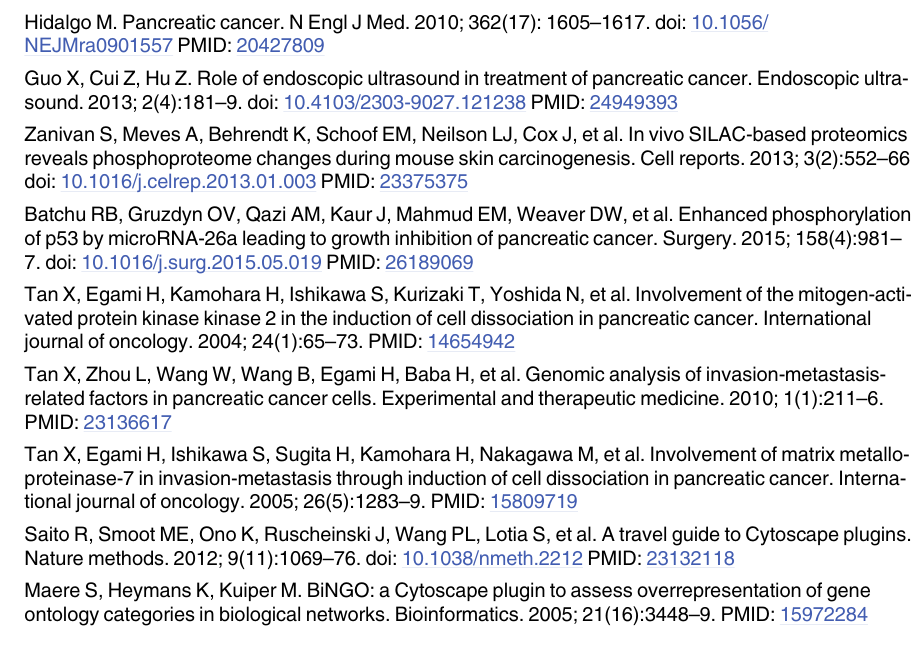
S1 Table. Primer sequences and inhibitor used in the assay. Real-time PCR was performed to analyze the level of FOS or IRS-1 mRNA in the knockdown cell lines. The level of Raf1 knockdown was confirmed using Western blot. S2 Table. The Phospho Explorer Antibody Array was scanned on a GenePix 4000 scanner. S3 Table. The expression of all proteins of the Phospho Explorer Antibody Array were pre- sented. The coordinates and proteins were indicated in the